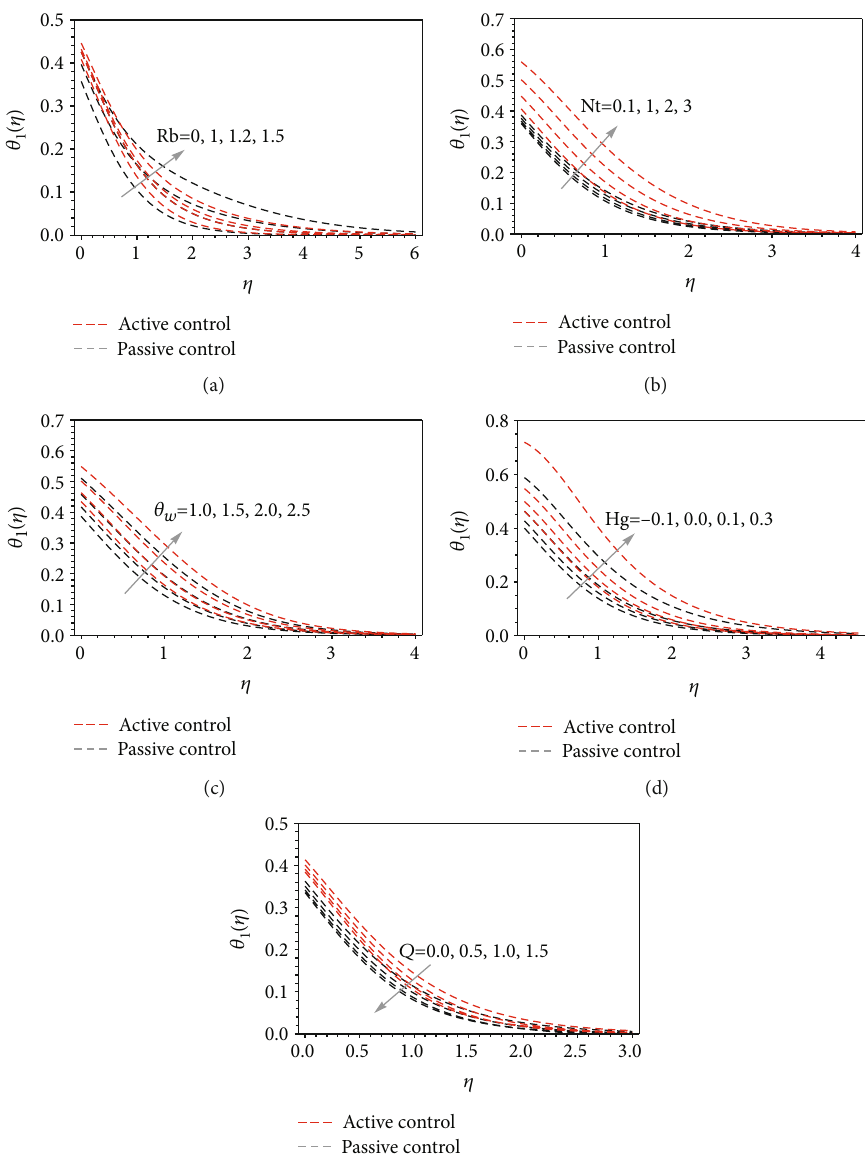
Figure 4: Temperature pro fi les for various values of Rb, Nt, Hg, θ